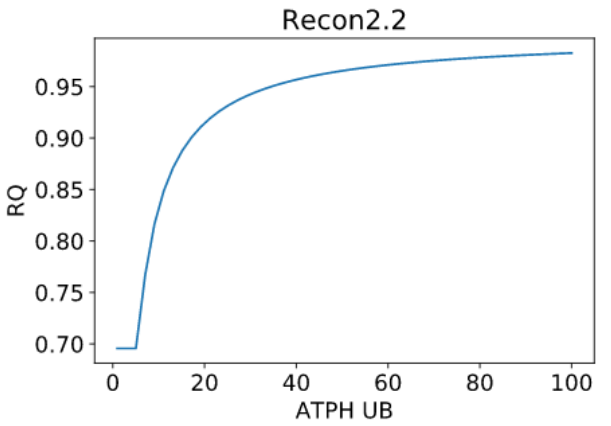
Figure 4. RQ changes are independent on intake fluxes. Predicted RQ for varying levels of ATPH upper bound. Intake bounds for palmitate and glucose were kept constant. Glucose uptake upper bound: 4.5 mmol/gDw/h. Palmitate uptake upper bound: 0.38